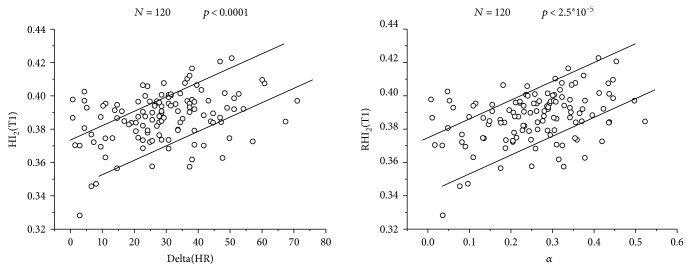
Correspondence between (RHI2 (T1)) and ΔHR and between RHI2 (T1) and α.